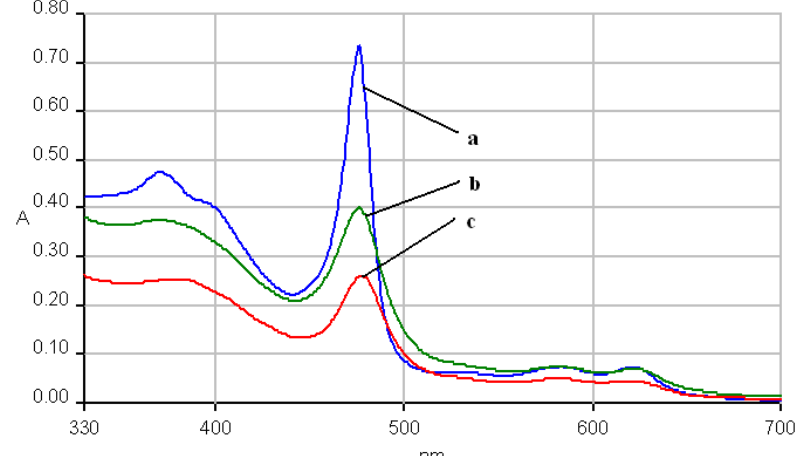
Figure 10. The overlapped UV-vis spectra of 2b (line a), and of the hybrid silica material 2b-AB (line b-pH = 11 and line c-pH = 12), in